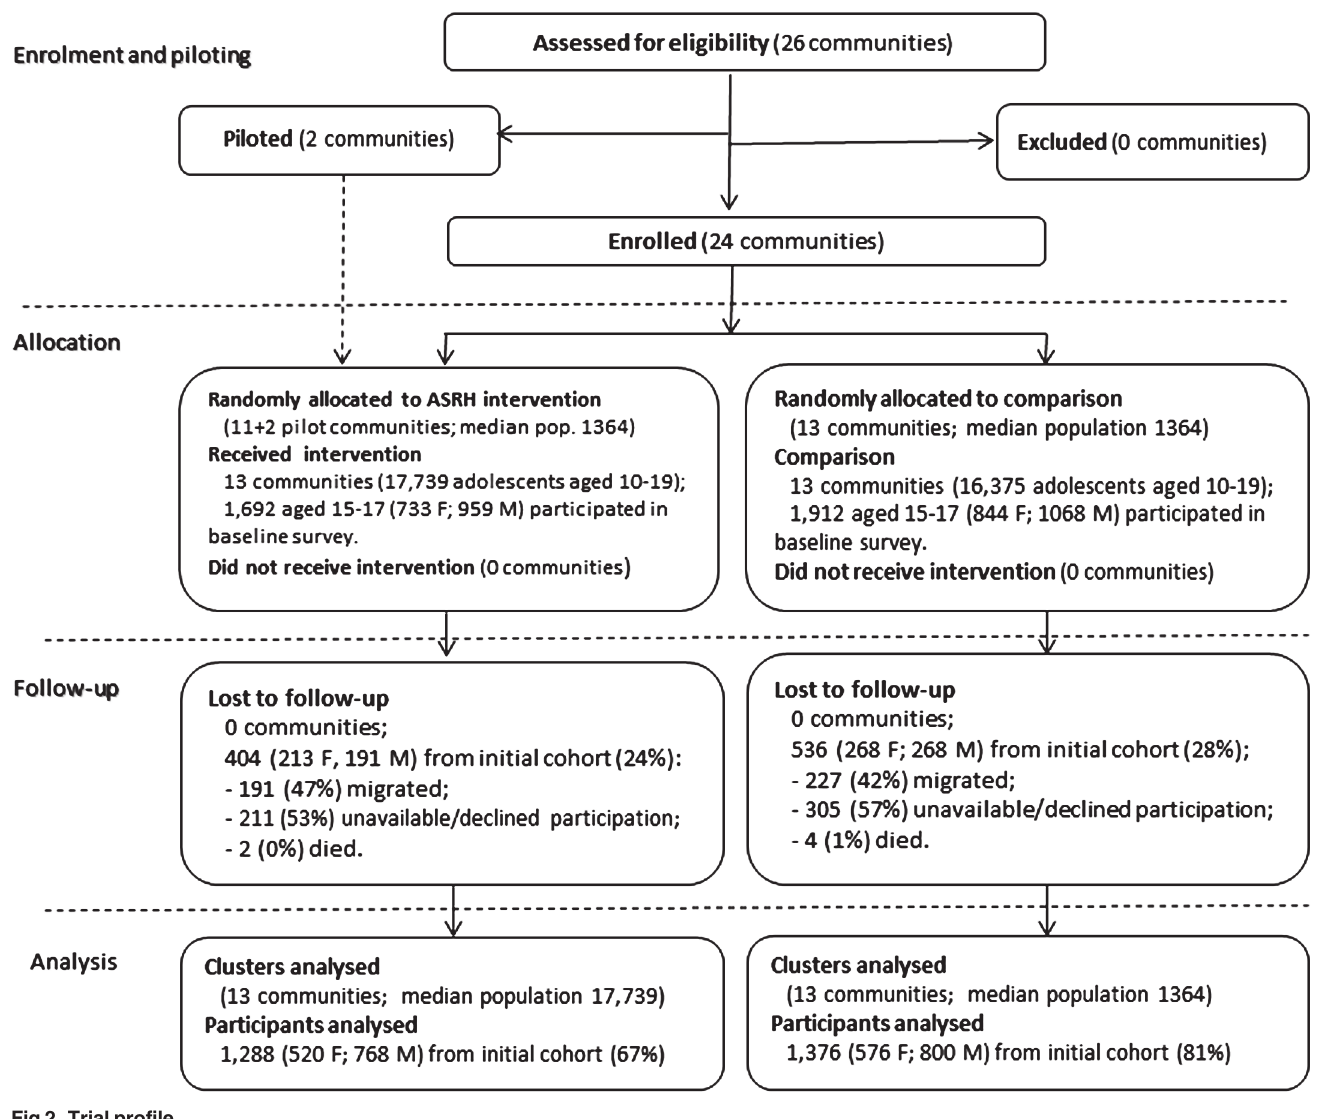
Table 1 shows frequencies of demographic characteristics at baseline, comparing adoles- cents in intervention and comparison sites, disaggregated by gender. Average participant age was 16 at baseline in both intervention and comparison communities. Most participants at- tended primary (52%) or junior high school (35%). Significant demographic differences be- tween intervention and comparison participants included a higher percentage of comparison participants attending primary school (39% versus 36%) and identifying as Catholic (49% ver- sus 44%), and a lower percentage identifying as Muslim (6% versus 11%). No significant differ- ences were found between communities in sexual experience among either boys or girls or pregnancy experience and parity among girls.